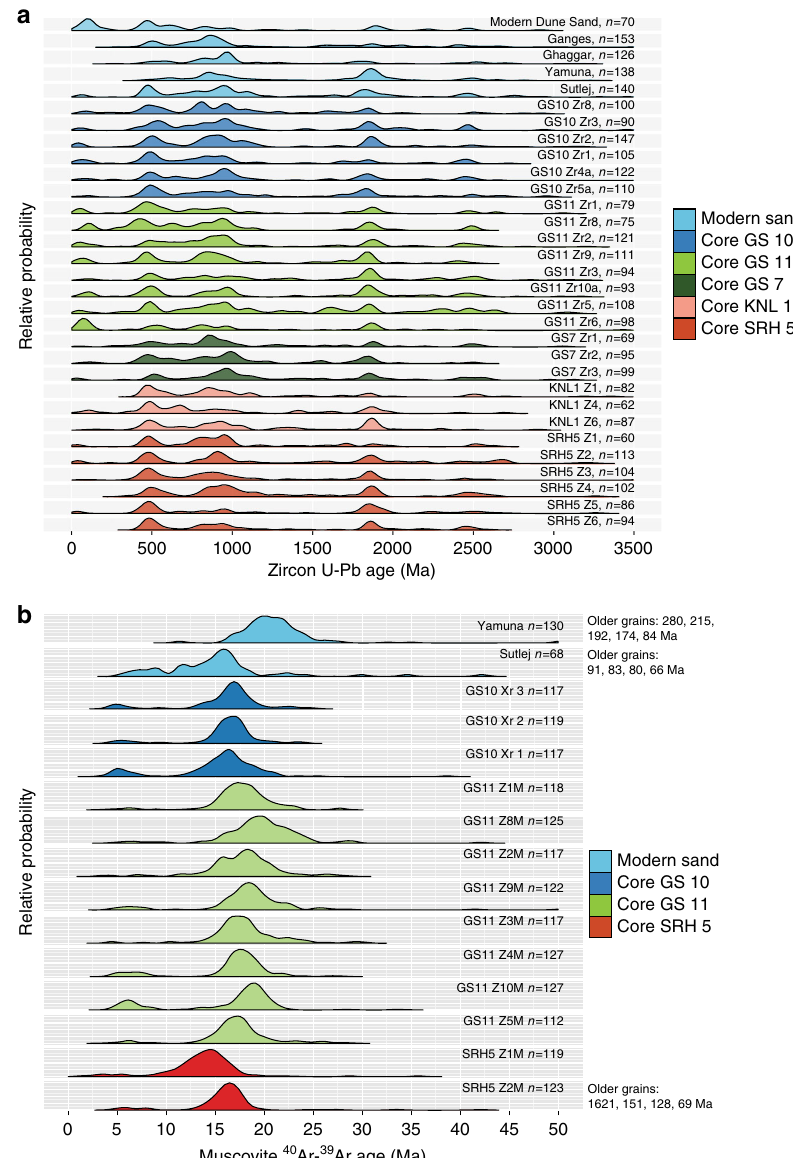
Fig. 9 Age distributions of detrital zircon and muscovite grains for core, modern river, and aeolian dune sand samples. a U-Pb detrital zircon age distributions. Modern Sutlej sand shows a peak at ~480 Ma that is not prominent in Yamuna, Ghaggar and Ganges modern river samples. All fl uvial sand samples from cores show distributions that match modern Sutlej river sand, thus identifying Sutlej catchment as the source of the fl uvial sand underlying the Ghaggar – Hakra palaeochannel. A palaeo-Yamuna River cannot be ruled out as an additional contributor to GS and KNL1 sands, but cannot be a contributor to SRH5. Only GS11-Zr6 shows a different distribution; this sand is interpreted as an aeolian deposit below the fl uvial succession and shows a good match to the modern Thar Desert dune sand. Sample locations shown in Figs. 2 and 4, and detailed in Supplementary Tables 1 and 3. Sample points in cores shown in Figs. 5, 8 and Supplementary Fig. 4, and described in Supplementary Table 4. b 40 Ar/ 39 Ar detrital muscovite age distributions. Two prominent peaks at ~15 – 20 Ma and ~4 – 6 Ma are present in the core samples. Both populations are present in the modern Sutlej sample, but the younger population is not present in the modern Yamuna sample, implying that the Sutlej catchment must be a contributor to fl uvial sediments in the core. A palaeo-Yamuna River cannot be ruled out as an additional contributor to the GS fl uvial sands but could not have contributed to the SRH5 fl uvial